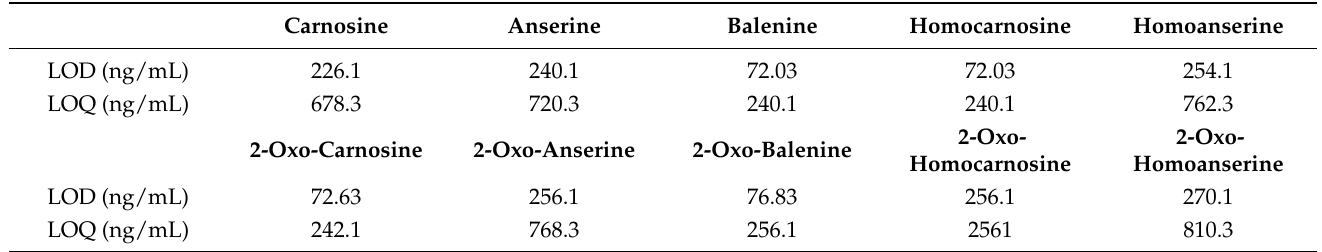
Table 3. LOD and LOQ of IDPs and 2-oxo-IDPs.